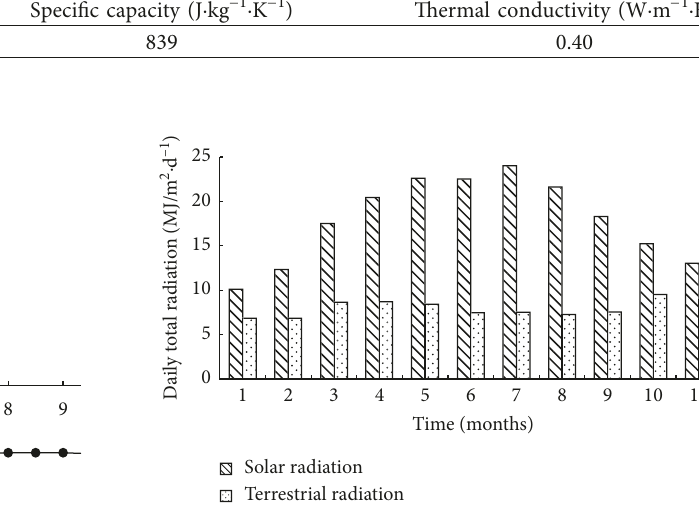
Figure 5: Initial ground temperature at different depths. Figure 6: Field observed data for solar and ground